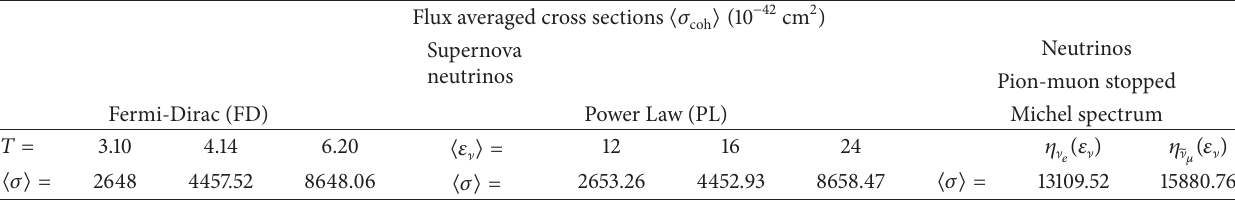
⟩ (in units 10 −42 cm 2 ) for 114 Cd isotope obtained in the case of neutrino energy spectra Table 2: Flux averaged coherent cross sections ⟨𝜎 coh coming from two neutrino sources: (i) supernova neutrinos and (ii) laboratory